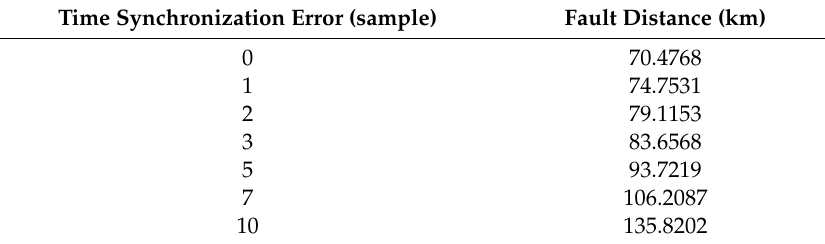
Table 6. Fault distances for varying time synchronization error.